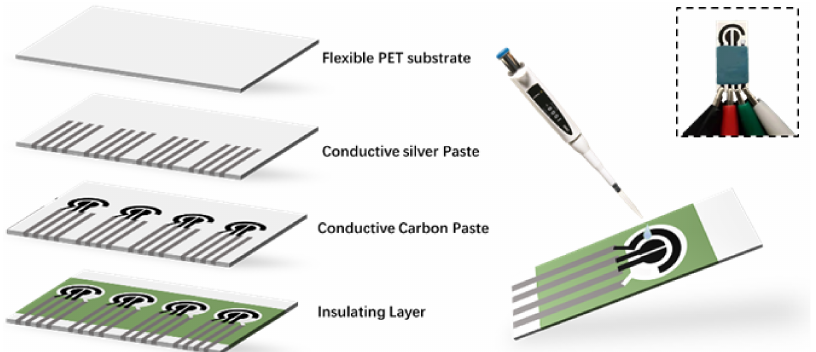
Figure 1. Schematic diagram of the fabrication process of the dual-analyte biosensor. The inset shows the photograph of the dual-analyte